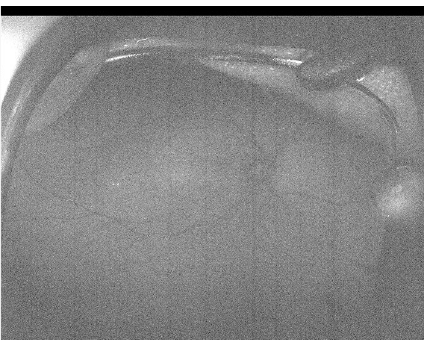
Figure 4. Fundus autofluorescence of case #4 at 62 weeks of corrected gestational age. Note that the retinal vessels can be followed throughout their trajectory in the temporal and nasal retina (approximate peak emission for fluorophores: λ610 nm; range for excitation maxima for the different fluorophores: λ430 nm – λ510 nm) 6